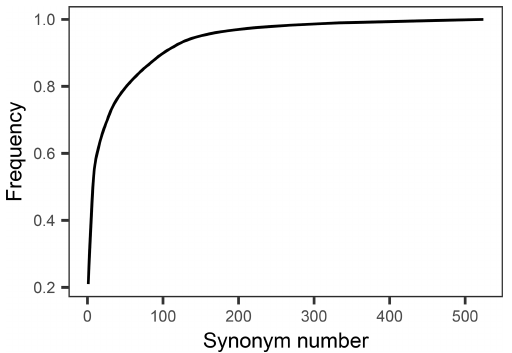
Figure 7. The problem of the absence of standardisation in param- eter names. The cumulative frequency of synonyms for seawater temperature in our initial database (Sect. 2.2.1), showing that there are over 500 different names for the same parameter and that many of these are